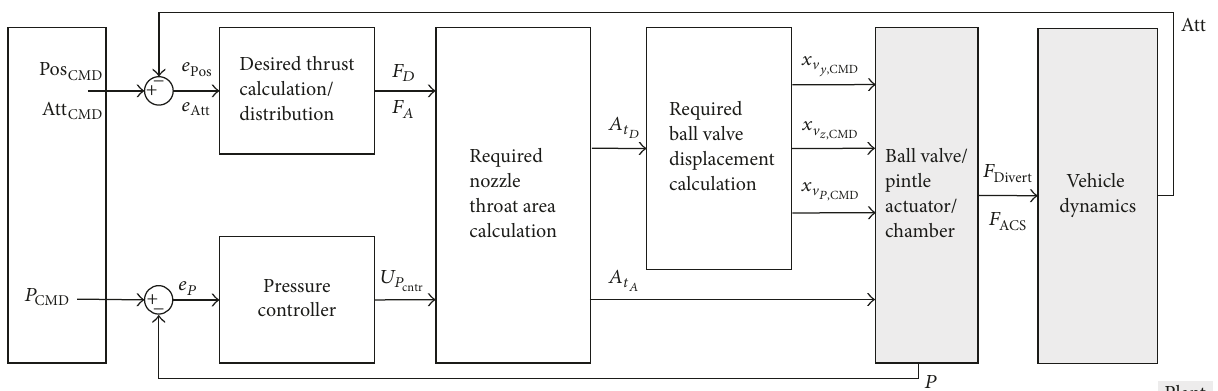
Figure 11: Control loop for the reduced actuator set.